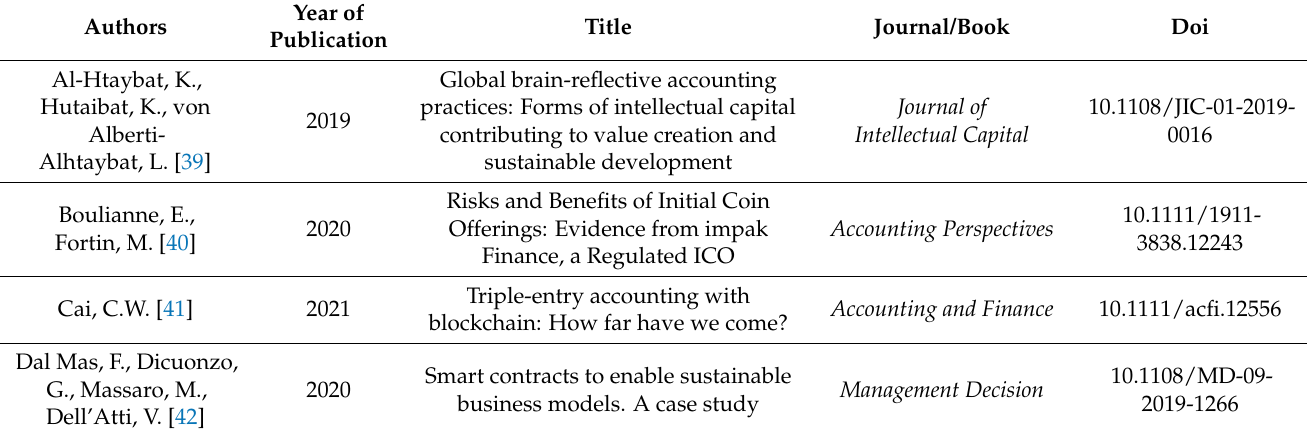
Table 1. Details of studies selected for